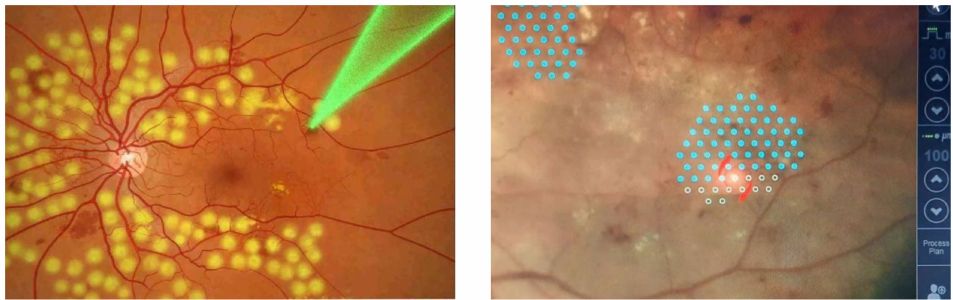
Figure 2. An example of applying coagulates manually ( left ) and with the Navilas software ( right